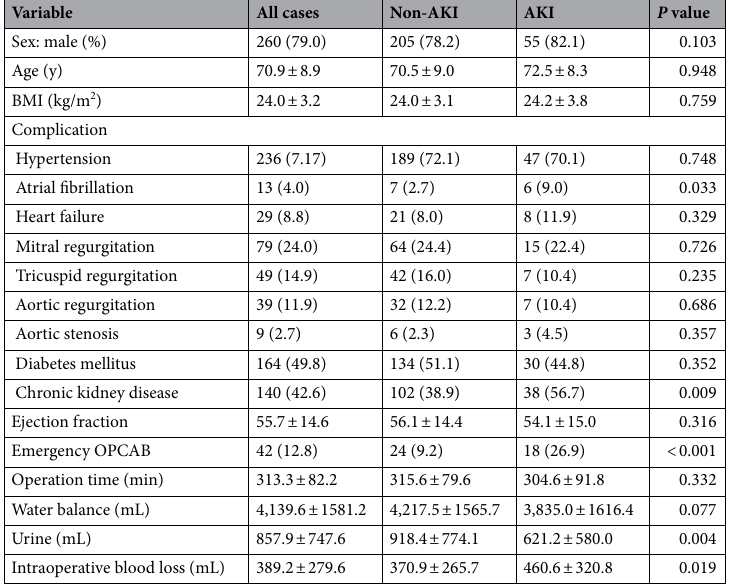
Table 2. Patients’ baseline characteristics. AKI: acute kidney injury, BMI: body mass index, OPCAB: off-pump CABG.